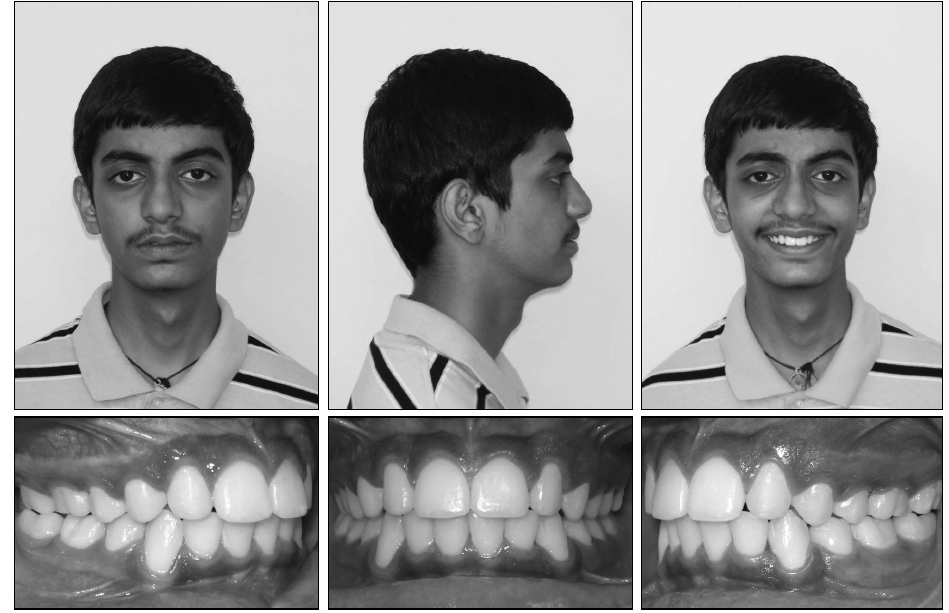
Figure 5. Immediately